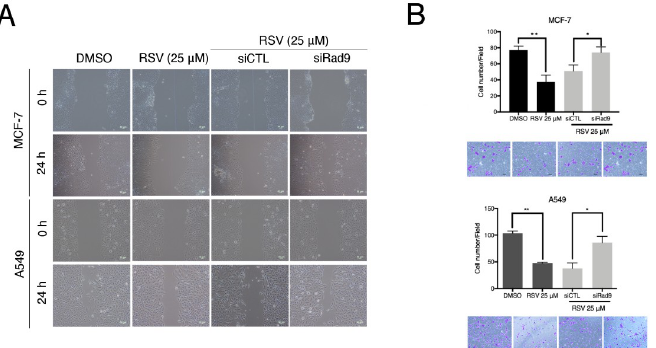
Fig 6. RSV inhibited cell mobility in a Rad9-dependent manner. (A) Scratch wound healing assay was performed to examine the effects of RSV treatment and Rad9 gene silencing on MCF-7 and A549 cells. Scale bar, 100 μ m. (B) The effects of RSV treatment and Rad9 gene silencing on MCF-7 and A549 cells invasion. Cells that had invaded to the bottom of the membrane were counted manually after staining with crystal violet. Scale bar, 100 μ m. �� , ��� P � 0.05 based on Student’s